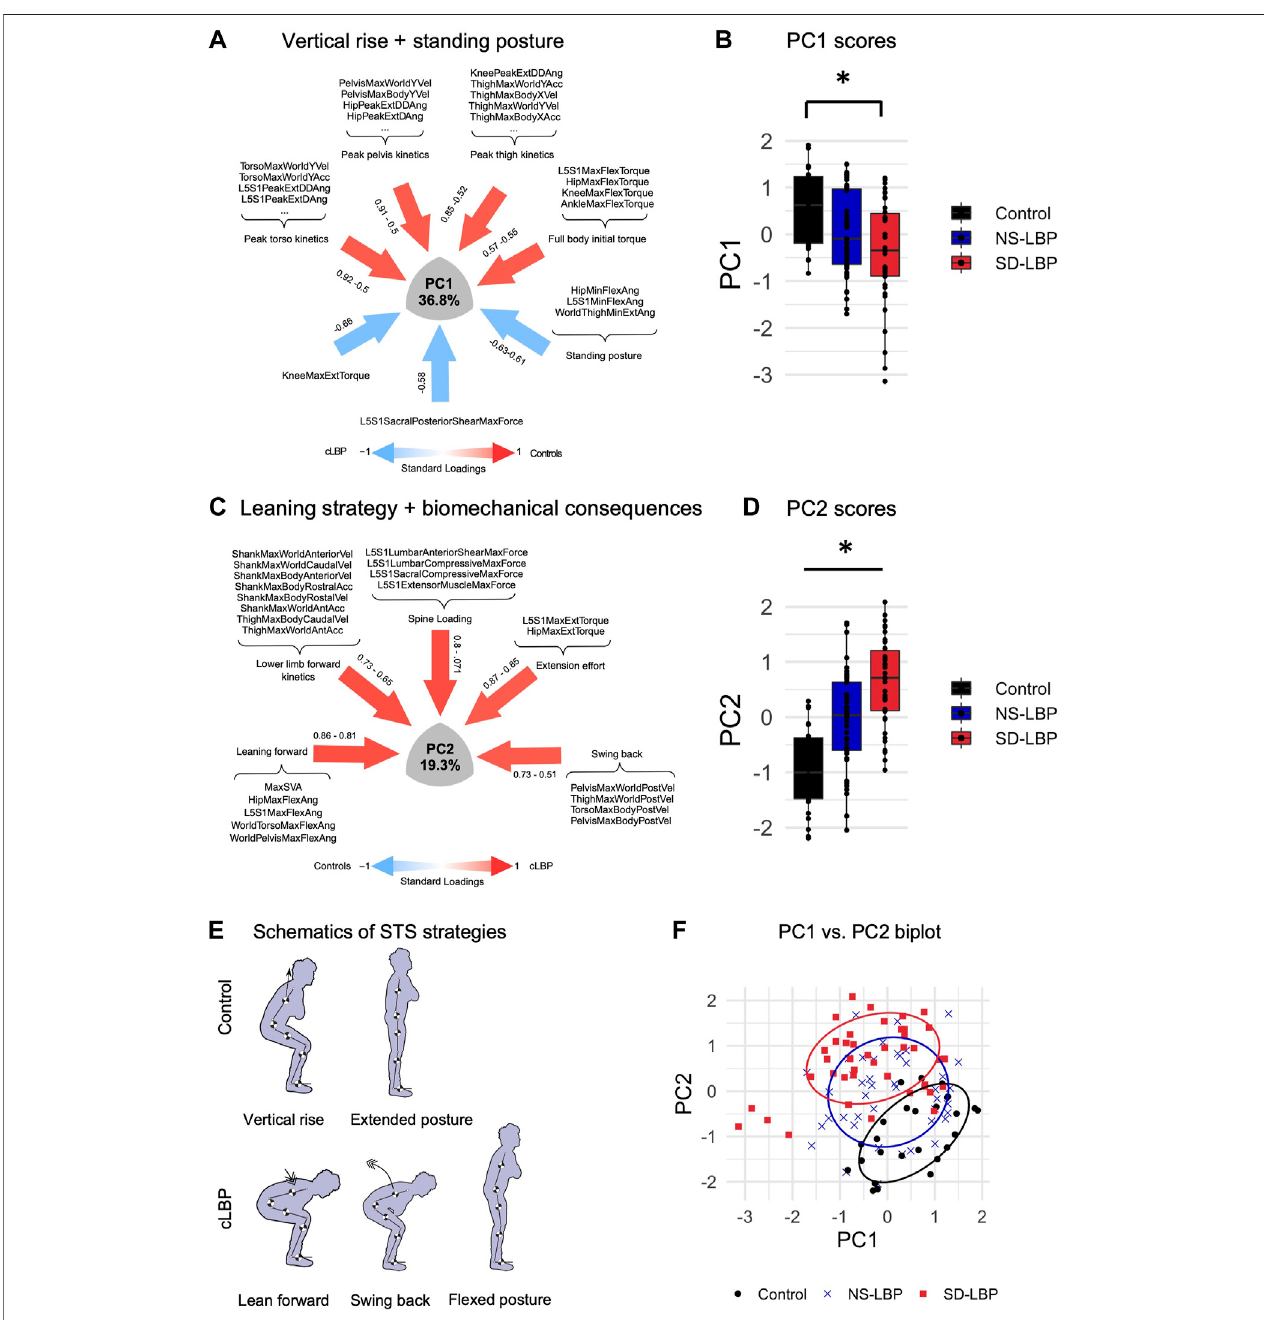
FIGURE2| NLPCAonfullbodybiomechanicsseparatesacrosstwopatientsubgroupsandhealthycontrolsbasedonSTSstrategies. (A) SyndRomicsplotofPC1 loadings. Kinetic variables with highest loadings were grouped based on body segment to identify the underlying construct of vertical rise strategy. (B) Boxplot of PC1 scoresgroupdata.Controls had signi fi cantlyhigher PC1 scorescomparedtoSD-LBP group. (C) SyndRomicsplotofPC2 loadings. Thevariables weregroupedbased on their biomechanical identity (kinetic, kinematic, dynamics or muscle forces) revealing the underlying construct of leaning sit-to-stand strategy that results in increased spinal loading requiring a more laborious extension effort in patients with LBP vs. controls. (D) Boxplot of PC2 scores group data. There was a signi fi cant differencebetweenallthreegroups. (E) Schematicrepresentation ofthecontrolandLBPpatientsit-to-stand(STS)strategiescaptured inPC1andPC2.F.PC1 vs.PC2 biplotvisualizesthegroupseparationin2Dspace.*Signi fi canceestablishedat p ≥ 0.5;ANOVAonPC1scores:F(2,108)=7.55, p =0.0008).Tukeyposthoc:controlvs. SD-LBP group ( p =0.0005);NS-LBPvs. controls( p =0.066); NS-LBPvs. SD-LBP ( p =0.148).ANOVA onPC2 scores:F(2,108) =30.091, p < 0.0001), Tukeypost-hoc: control vs. NS-LBP ( p =0.0001); control vs. SD-LBP group ( p < 0.0001); NS-LBP vs. SD-LBP ( p =0.0004).